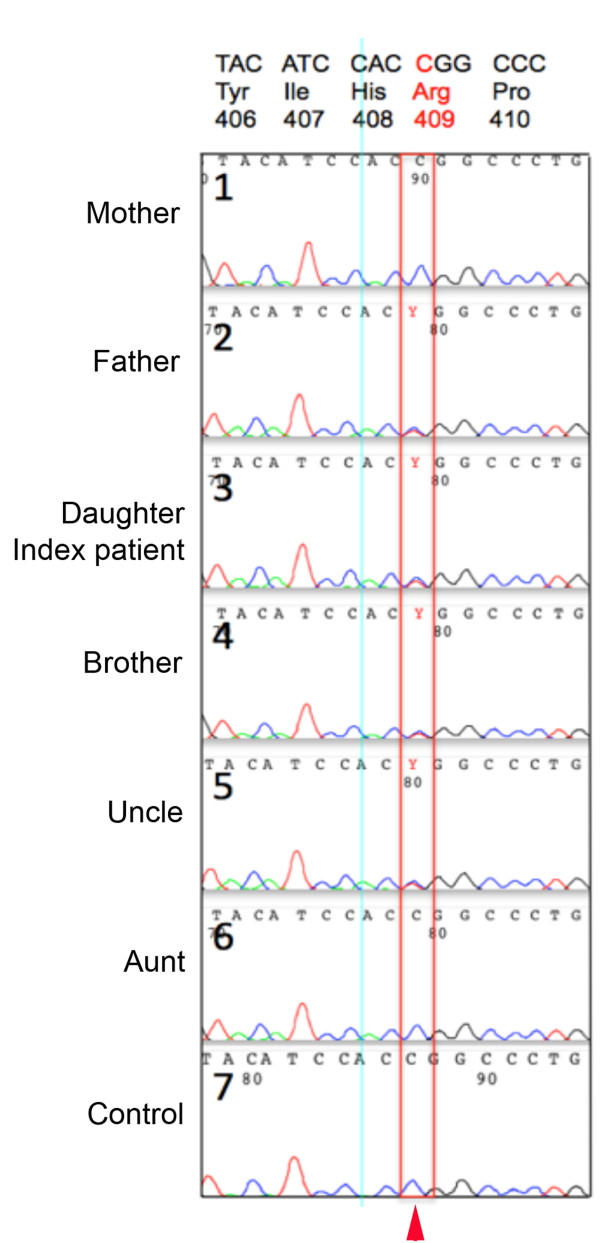
Electropherogram results of CLCN7 exon 15 sequencing derived from a family with a history of autosomal dominant osteopetrosis-II and a control individual. The c.1225C>T position is indicated. Codon CGG is changed to TGG (p.Arg409Trp).